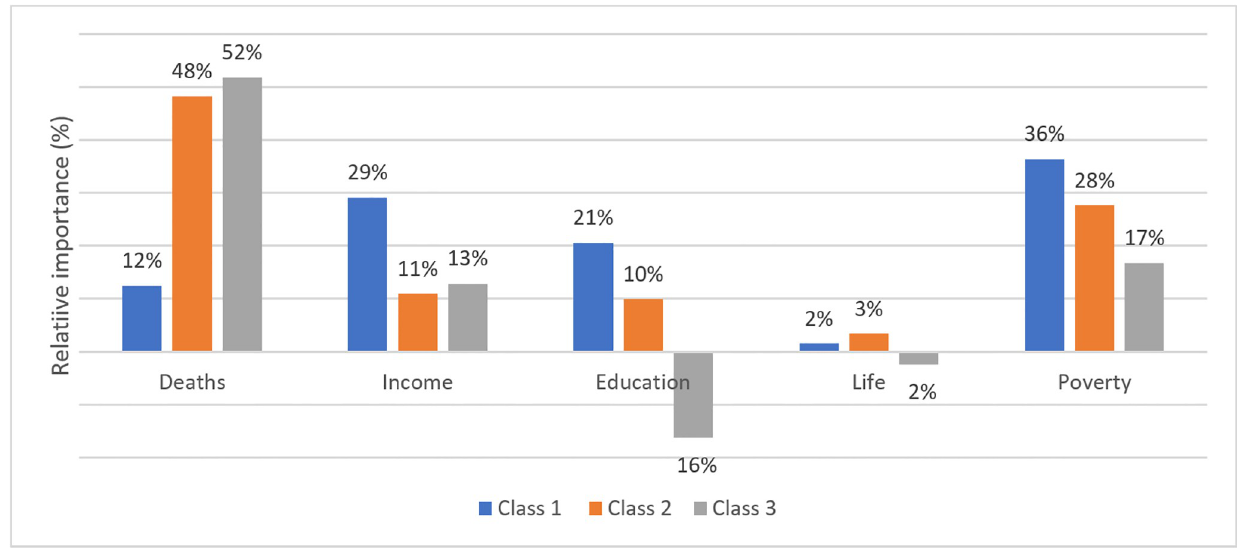
Fig 3. Relative importance of attributes per class. Note: The relative importance is computed by taking the absolute value of the maximum level of each attribute and dividing them by the sum of the absolute value of all the maximum levels of each attribute, per class [32]. The downward bars for “Education” and “Life” attributes in Class 3 are purely illustrative, to convey that the valuation given to those attributes’ levels are contrary to rationally consistent